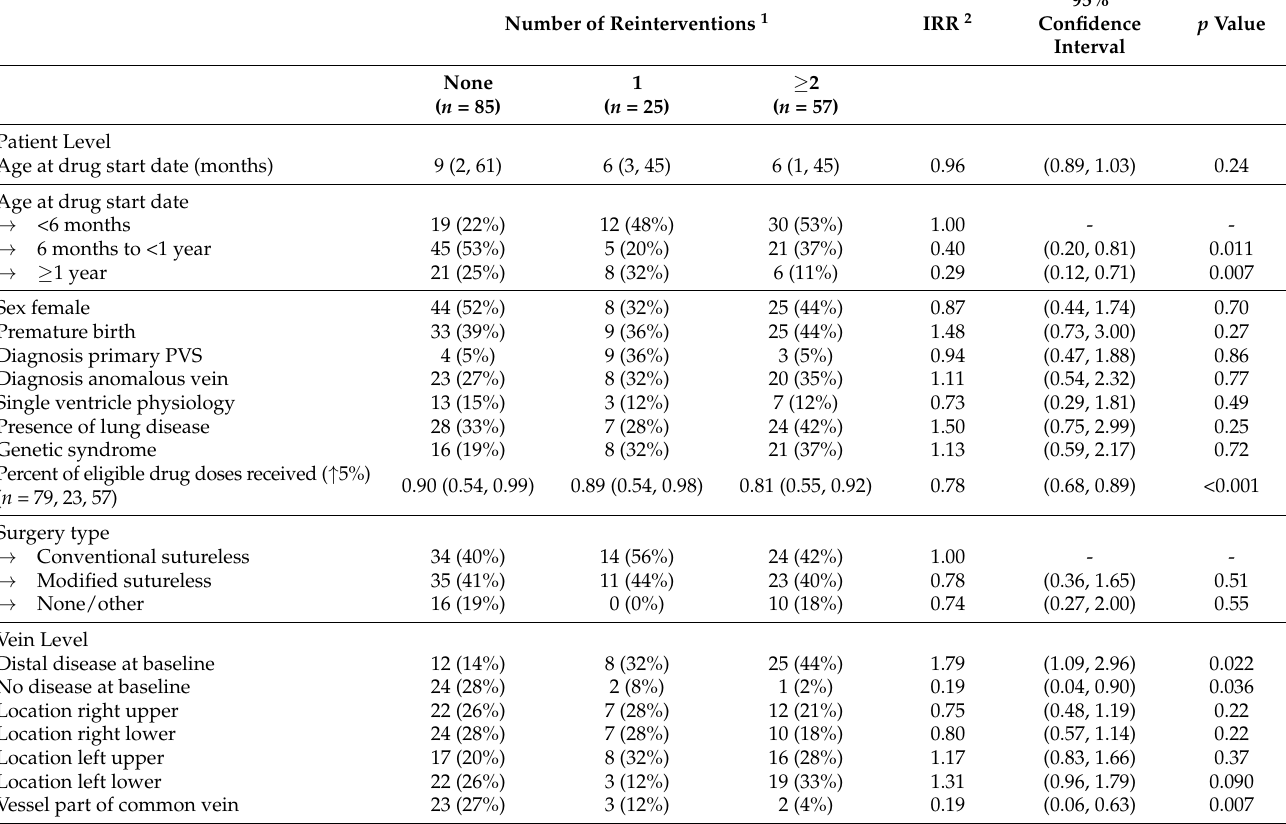
Table 6. Rate of reintervention during the study period: univariate analysis.